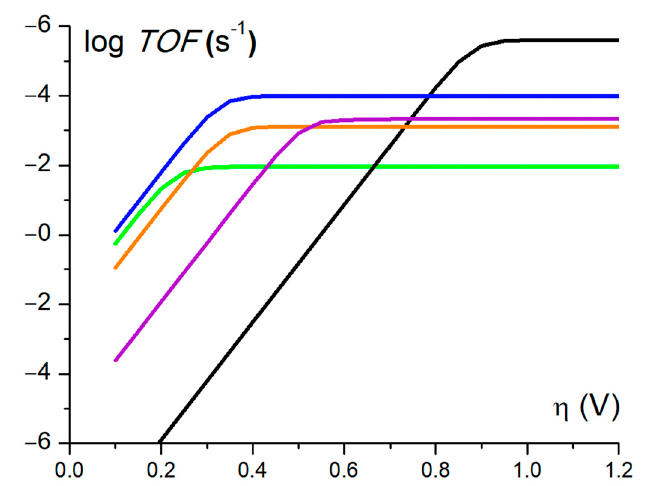
Figure 7. Catalytic Tafel plots: comparison of performances for HER catalysed by Ni 3 L 2 in DMF in the presence of 1M TFA (purple line) and NiL in DMF in the presence of 1M TFA (green line) [18,24] with other catalysts reported in the literature. Black: Fe II TPP, DMF, Et 3 NH + [34,35]; blue: [Co II (dmgH) 2 py], DMF, Et 3 NH + [25,34]; orange: [Ni II (P 2 PhN 2 C 6 H 4 X) 2 ] 2+ , X = CH 2 P(O)(OEt) 2 , MeCN, DMFH [34,36].